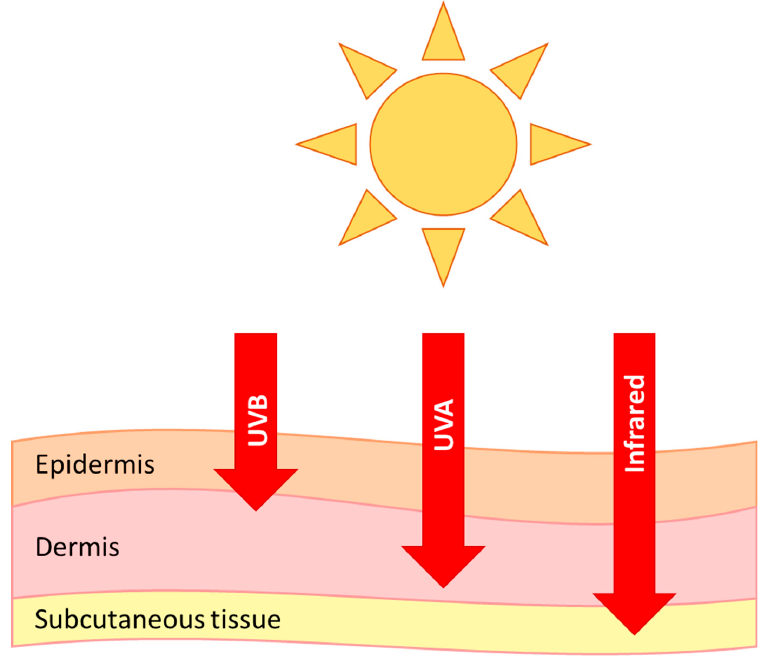
Figure 1. Penetration of UVB, UVA and infrared radiation into the skin.